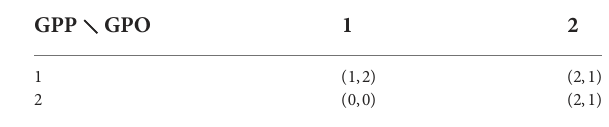
TABLE 2 Payoff bi-matrix for the case of n =